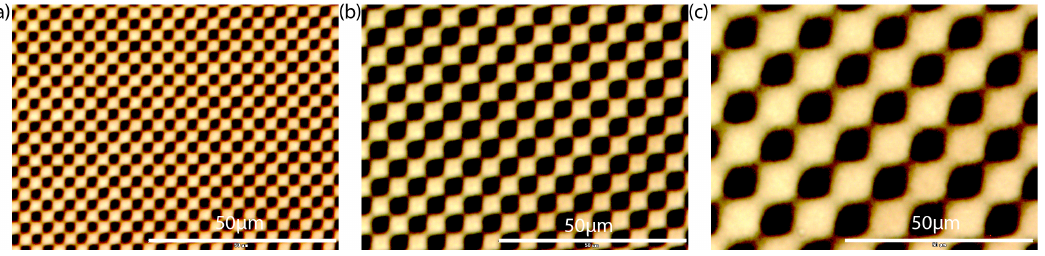
Figure 2. Micrographs of samples with checkerboard patterning with a ( a ) 3- µ m pixel size, ( b ) 5- µ m pixel size and ( c ) 10- µ m pixel size.